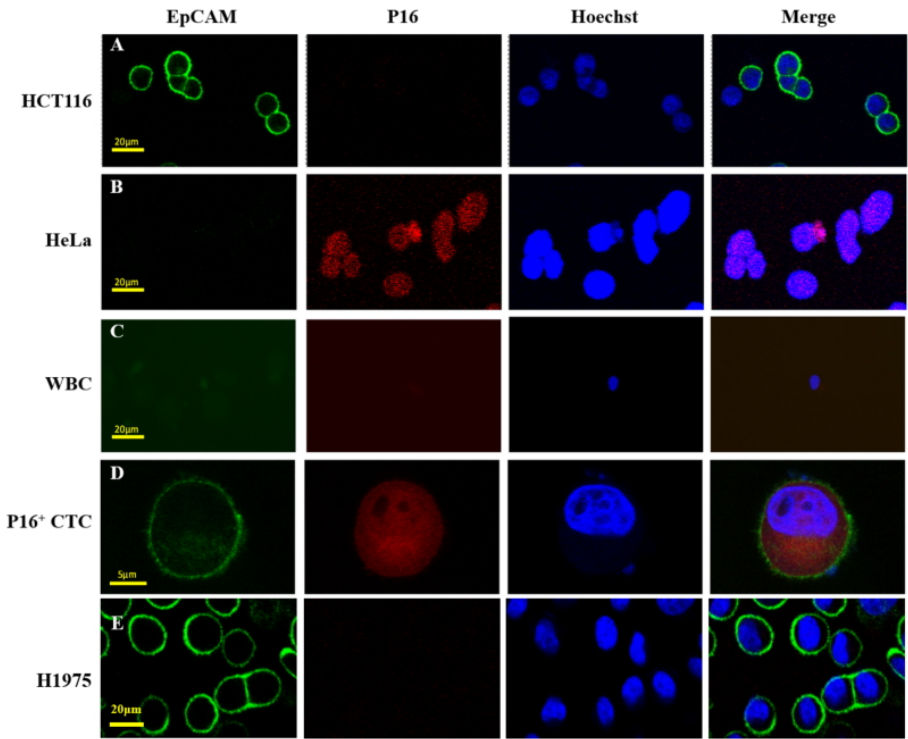
Figure 2. Demonstration of p16-positive circulating tumor cells identified in patients with oropha- ryngeal cancer. Immunofluorescence staining was used to identify cells in purified cells from blood samples. HCT116 ( A ) and HeLa ( B ) cells positively expressed EpCAM and p16, respectively. White blood cells (EpCAM neg /P16 neg /Hoechst pos ) ( C ) and p16-positive circulating tumor cells (EpCAM pos /P16 pos /Hoechst pos ) ( D ) were shown. H1975 cells ( E ) also serve as a positive control in this study.